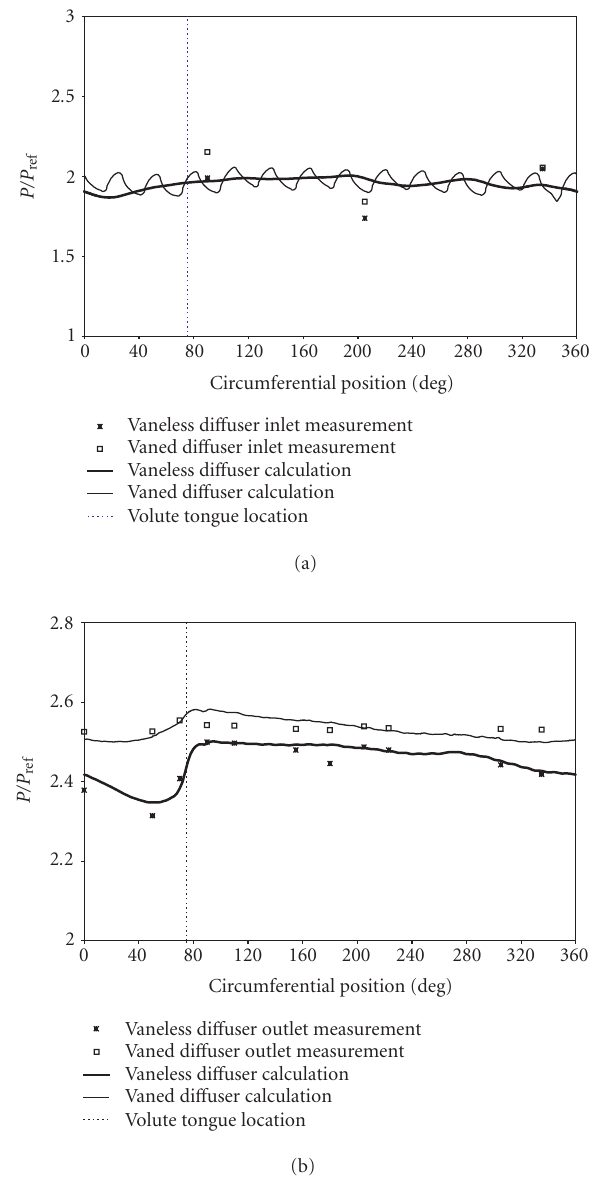
Figure 6: Static pressure at the (a) inlet and (b) outlet of the vane- less and vaned di ff users.